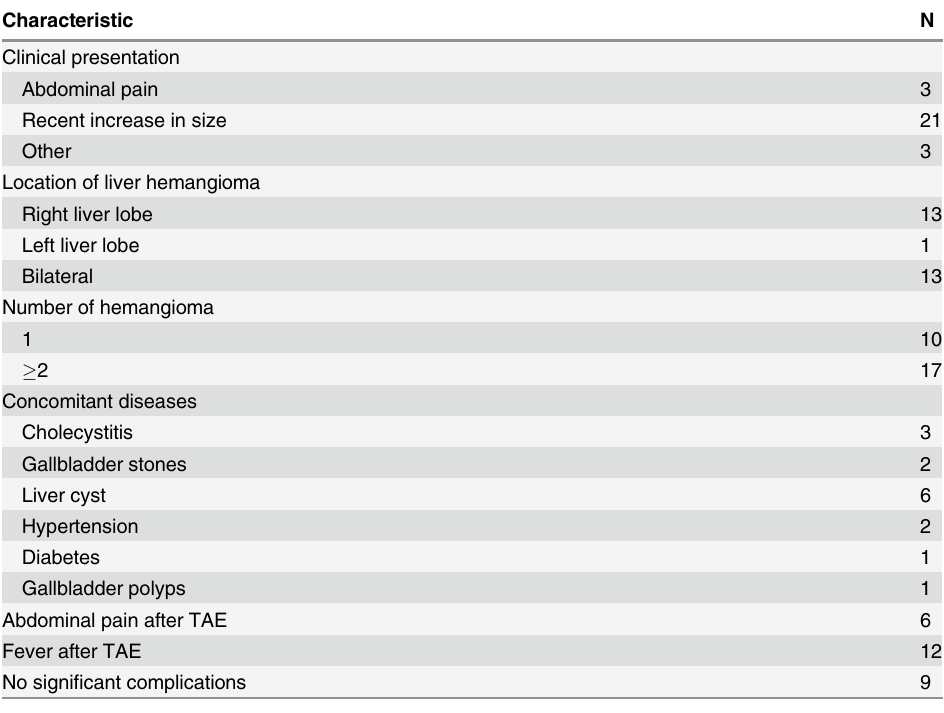
Table 1. Characteristics of 27 patients with giant hepatic